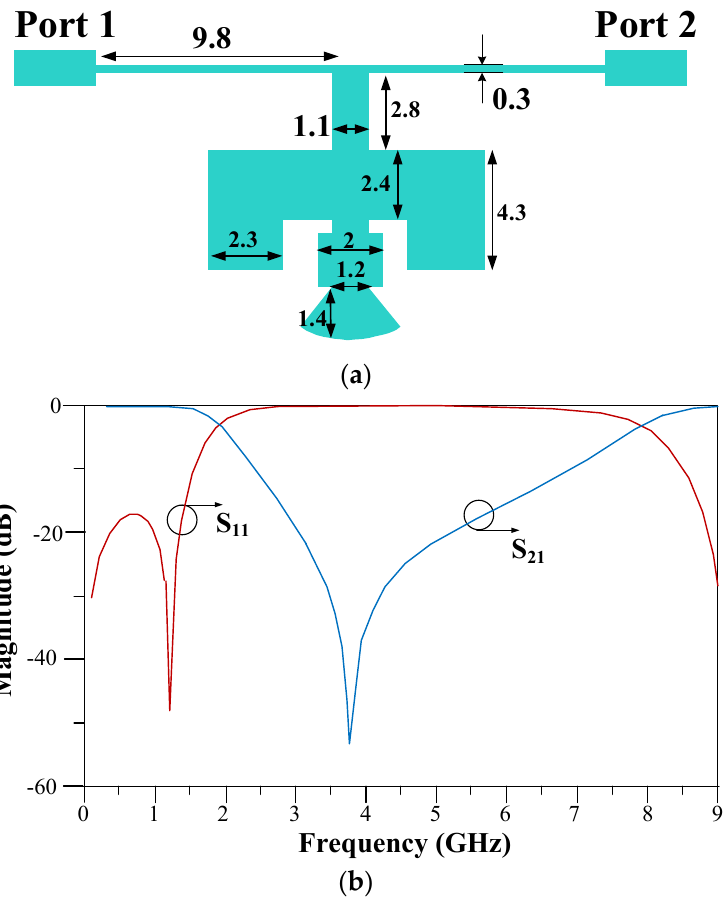
Figure 7. Improved initial horizontal resonator: ( a ) layout and ( b ) frequency response. All dimen- sions are in the millimeter unit. are in the millimeter